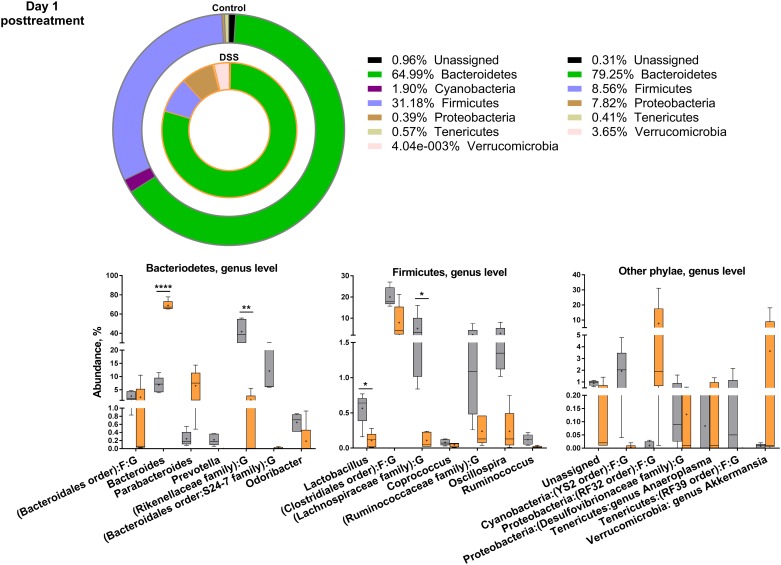
Distribution of the 20 most abundant phyla on day 1 post-treatment.Overview of relative phylogenetic distribution and details of variation down to genus level of gut microbiota of untreated control mice and mice during treatment with 1.5% dextran sulfate sodium (DSS). There were too few reads from DSS+Ampicillin and DSS+Ampicillin+LPS mice on day 3 and day 1 post-treatment. Verrucomicrobia amount on day 3 and day 1 post-treatment is for one mouse only. See S2 Table for analysis of variance.